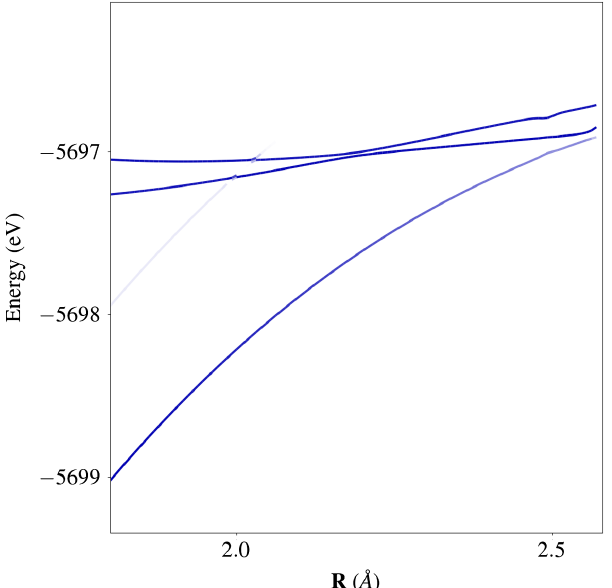
, coupling strength cav